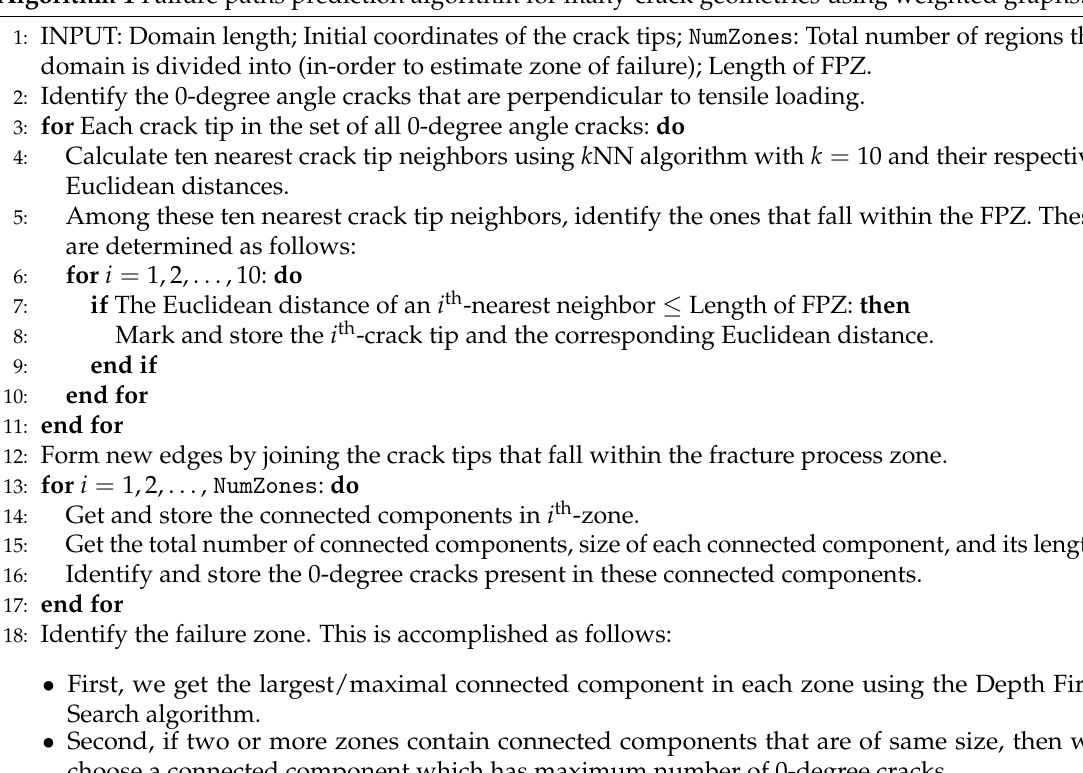
Algorithm 1 Failure paths prediction algorithm for many-crack geometries using weighted